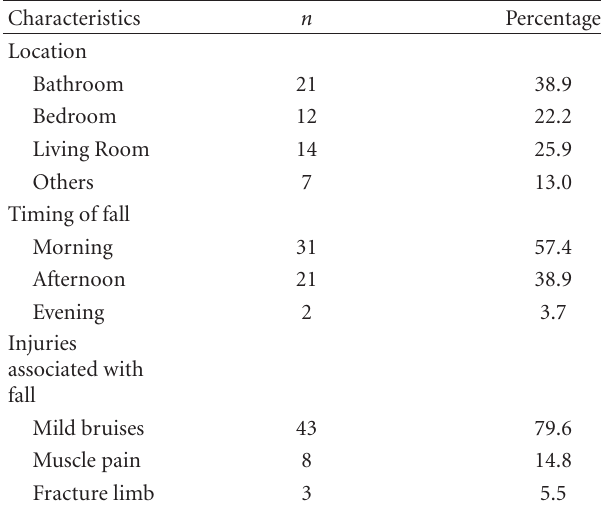
Table 2: Characteristics of fall episode ( n = 54).